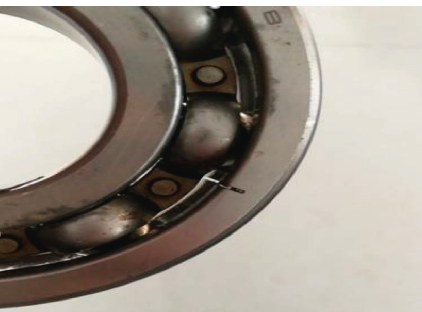
Figure 7: The fault diameter 0.5 mm outer race defect of the test rolling